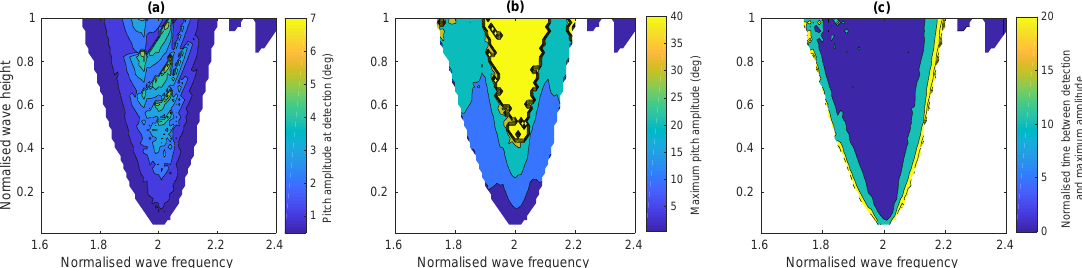
Figure 9. The performance of the early warning detection system in monochromatic waves. ( a ) The amplitude of the pitch displacement when the warning system detected parametric resonance. ( b ) The maximum amplitude of the pitch displacement when parametric resonance occurred (clipped at 40 ◦ , above which simulations always crashed). ( c ) The time between the when the warning system detected parametric resonance and when the maximum pitch displacement